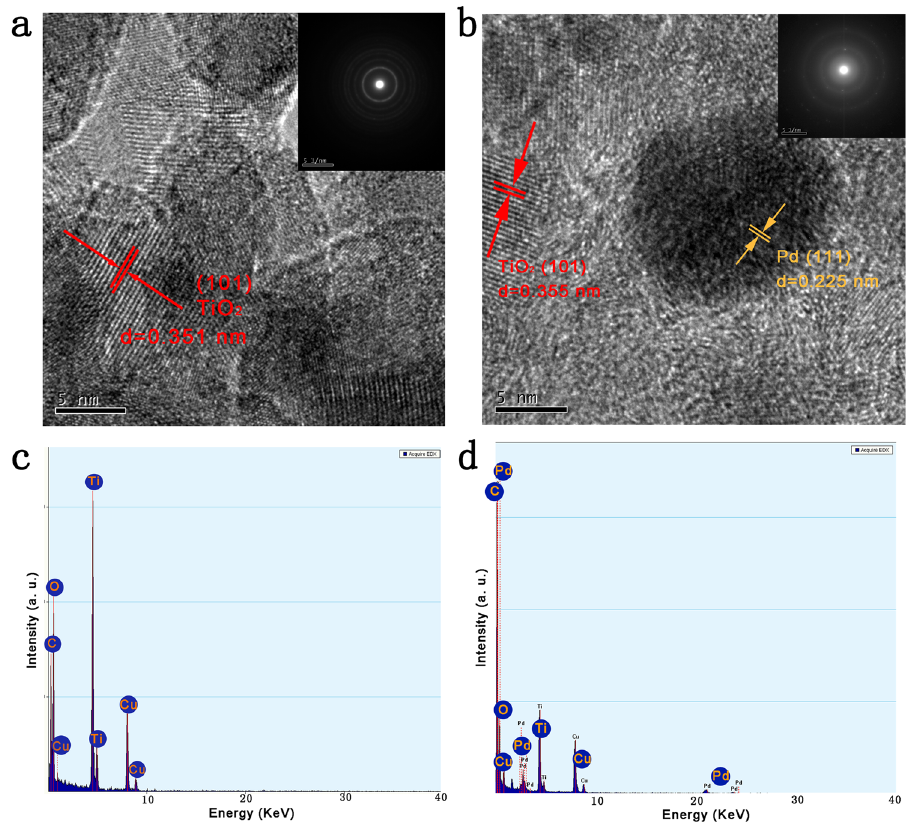
Figure 2. ( a ) HRTEM image of 10% Ⓕ -TiO 2 /AC. ( b ) HRTEM image of 2%Pd/10% Ⓕ -TiO 2 /AC. The insets of ( a and b ) are the corresponding SAEM images. ( c and d ) are EDX analysis of 10% Ⓕ -TiO 2 /AC and 2%Pd/10% Ⓕ - TiO 2 /AC, respectively.